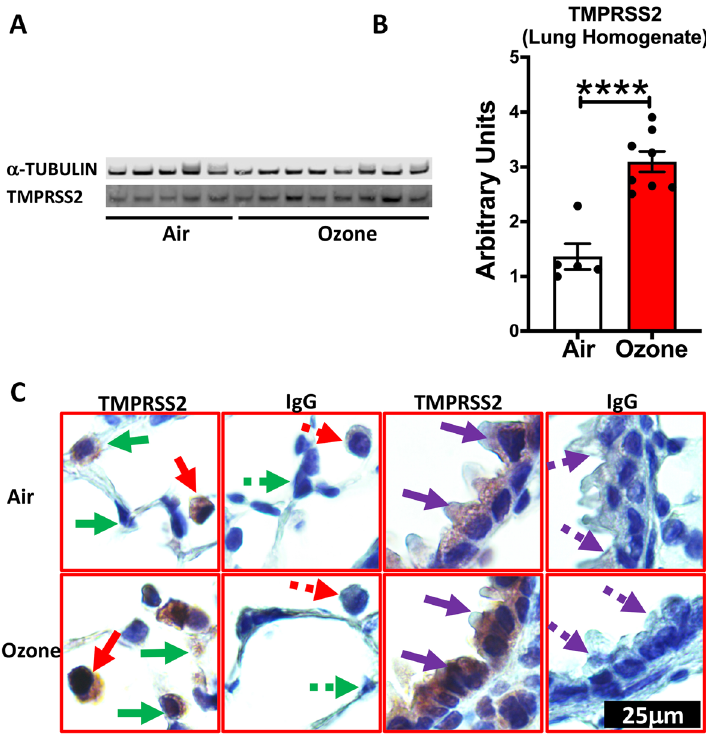
Figure 1. TMPRSS2 protein expression is upregulated in the lungs of ozone -exposed mice. Western blot representative gel image ( A ) showing bands for TMPRSS2 protein and alpha-tubulin loading control, and band intensity analyses ( B , Bar Graph) on the whole lung homogenate from air- and ozone-exposed mice (n = 6–8). ( C ) Immunohistochemical staining for TMPRSS2 in macrophages (solid red arrow), alveolar epithelial cells (solid green arrow), and bronchiolar epithelial cells (solid purple arrow). Negatively stained cells are indicated by dotted arrows in lung sections that were incubated with antibody (IgG) control. All images were captured at the same